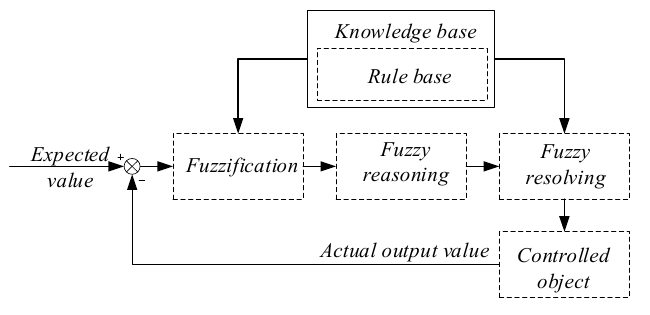
Figure 1. The basic structure diagram of a fuzzy controller.